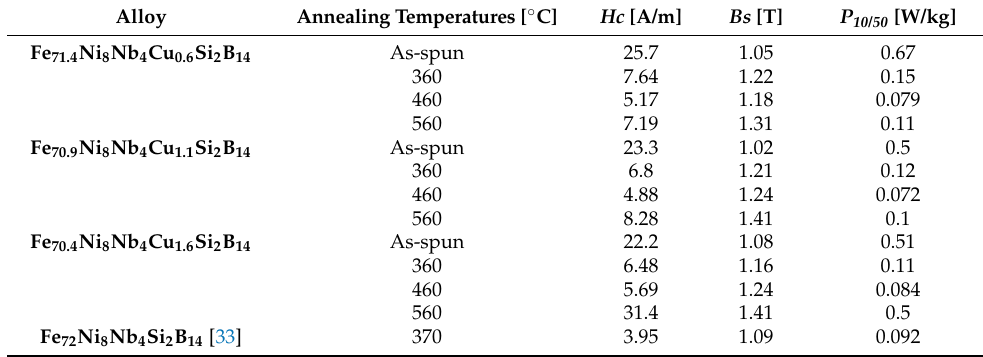
Figure 4. Coercivity Hc ( a ), magnetic saturation Bs ( b ) and core power losses P 10/50 ( c ) of measured cores. Table 1. Coercivity Hc , magnetic saturation Bs and core power losses P 10/50 of amorphous ribbon cores as-spun and annealed at characteristic temperatures.